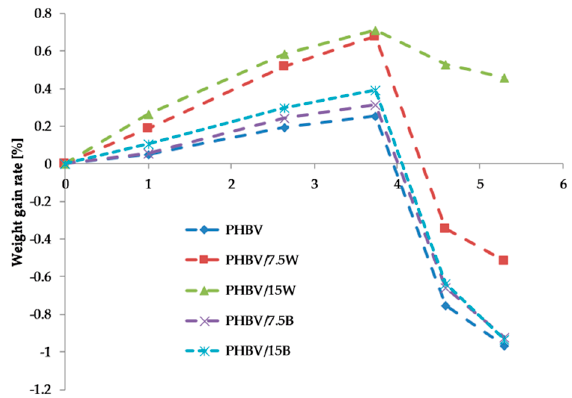
Figure 6. The weight gain rate (M t ) in function of the square root of the time. Table 2. Fickan’s diffusion coefficients of poly (3-hydroxybutyrate-co-3-hydroxyvalerate) (PHBV) composites. Composites h